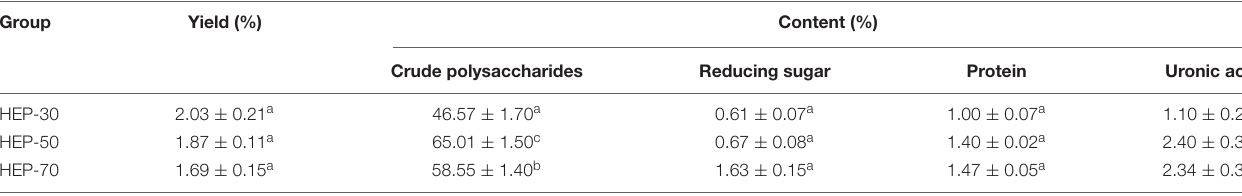
TABLE 1 | The main component content of different grades of Hericium erinaceus polysaccharides (HEPs). Group Yield (%)